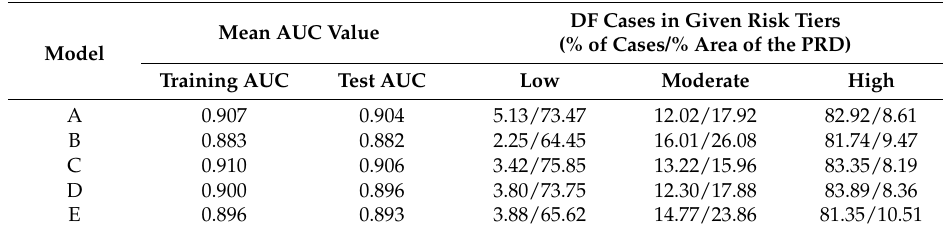
Table 4. Model validation